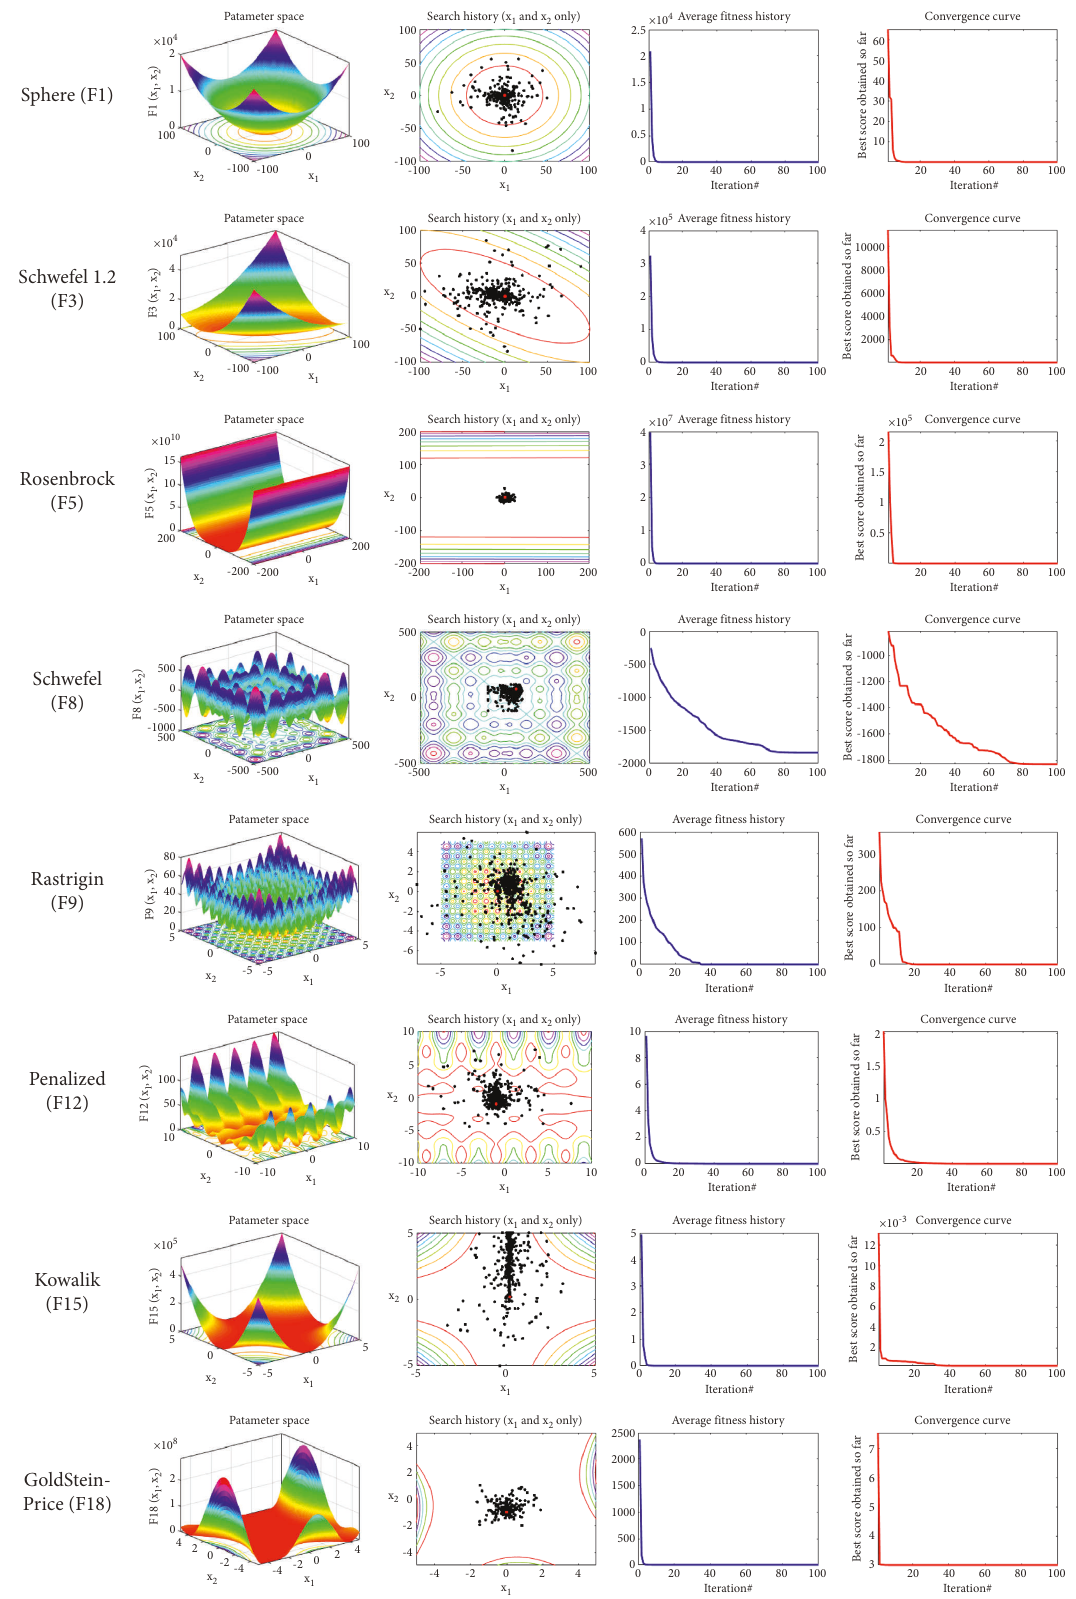
Figure 3: Qualitative metrics of six benchmark functions: 2D views of the functions, search history, average fitness history, and convergence curve using the IGBO